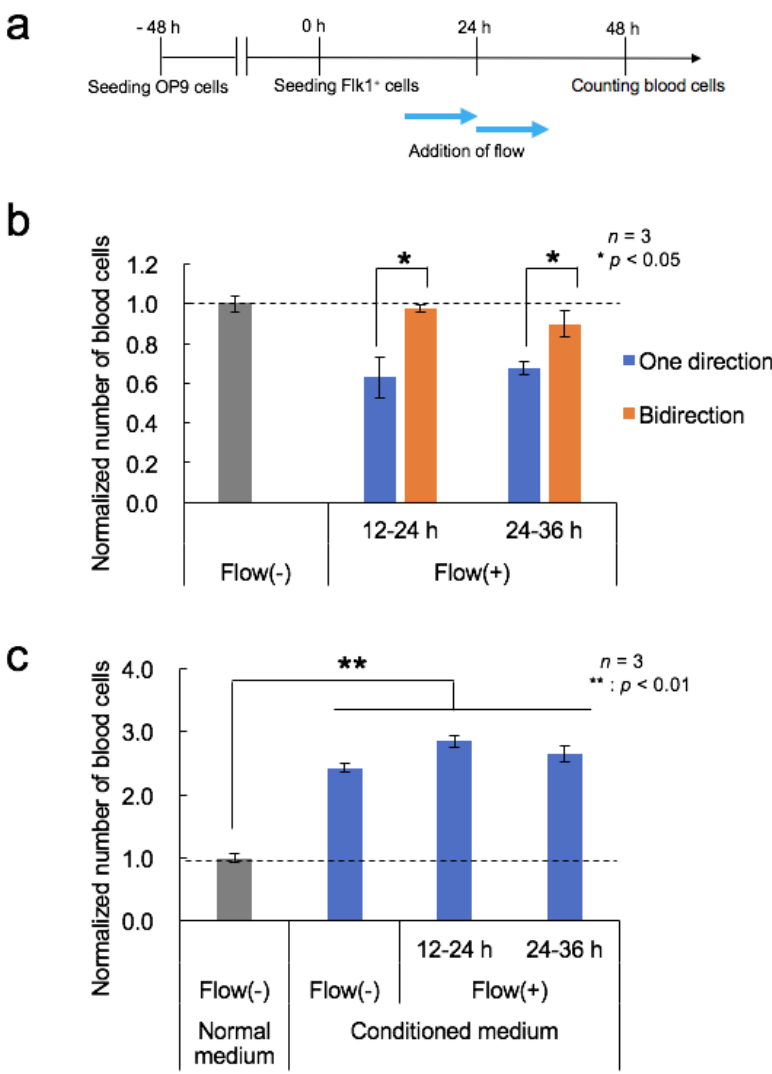
Figure 4. Effects of fluid flow stress and conditioned medium. ( a ) Timeline of the differentiation procedure and flow stimulation. ( b ) The number of blood cells generated from Flk-1 + cells cultured under unidirectional or bidirectional flow from 12 to 24 h or 24 to 36 h after seeding of cells. Mean ± SD, t -test, bidirectional versus one direction, *: p < 0.05, n = 3. ( c ) The number of blood cells arising from Flk-1 + cells in the conditioned medium. Mean ± SD, one-way ANOVA, **: p < 0.01, n =